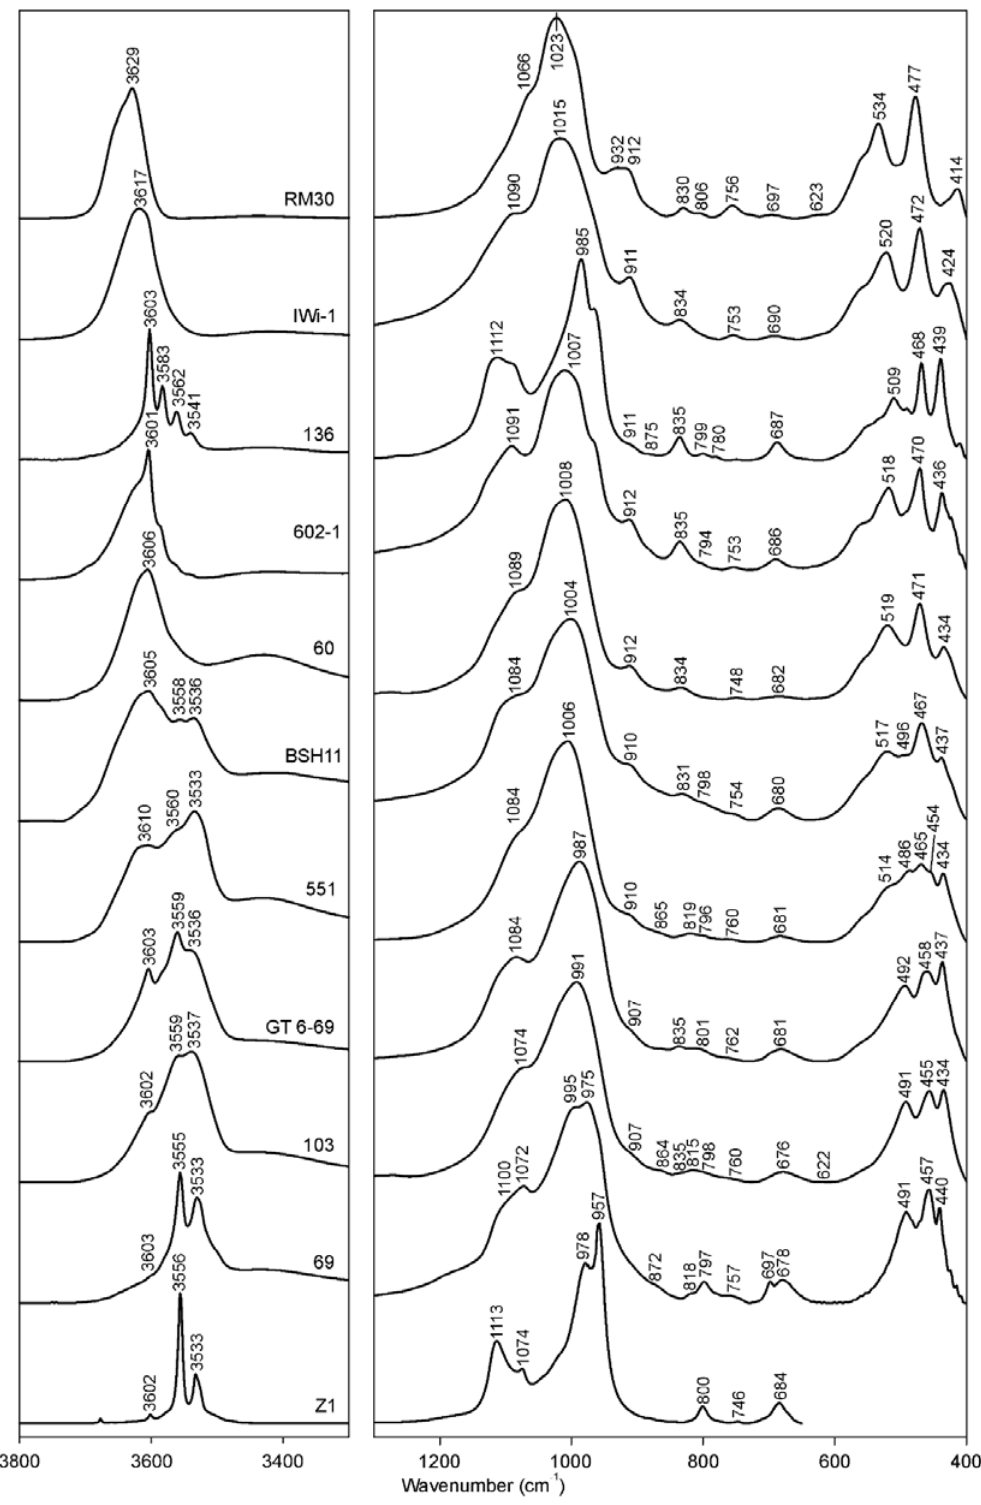
Figure 1. Selected FTIR spectra of K ‐ dioctahedral 1 M micas: RM30 ‐ (Mg, Fe) ‐ poor illite; Iwi ‐ 1 ‐ Mg ‐ rich illite; 136—aliminoceladonite; 602 ‐ 1—aluminoceladonite; 60—Mg ‐ rich, Fe ‐ bearing illite; BSH11—Fe ‐ illite; 551—Al ‐ glauconite; GT6 ‐ 69 and 103—glauconites; 69—celadonite; Z1—celadonite.